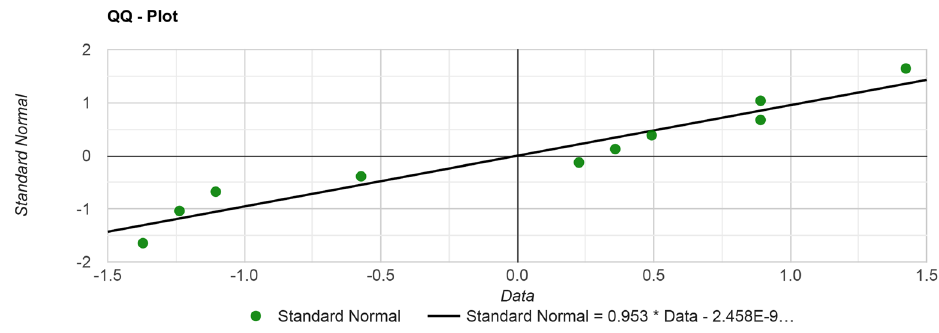
Figure 4. The depiction of accuracies normality using QQ